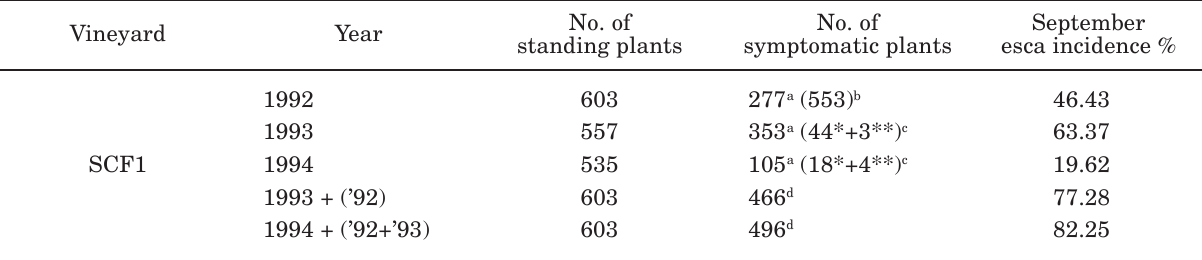
Table 2. Incidence of esca in a vineyard at San Casciano Val di Pesa (Florence), from 1992 to 1994. No. of No. Vineyard Year